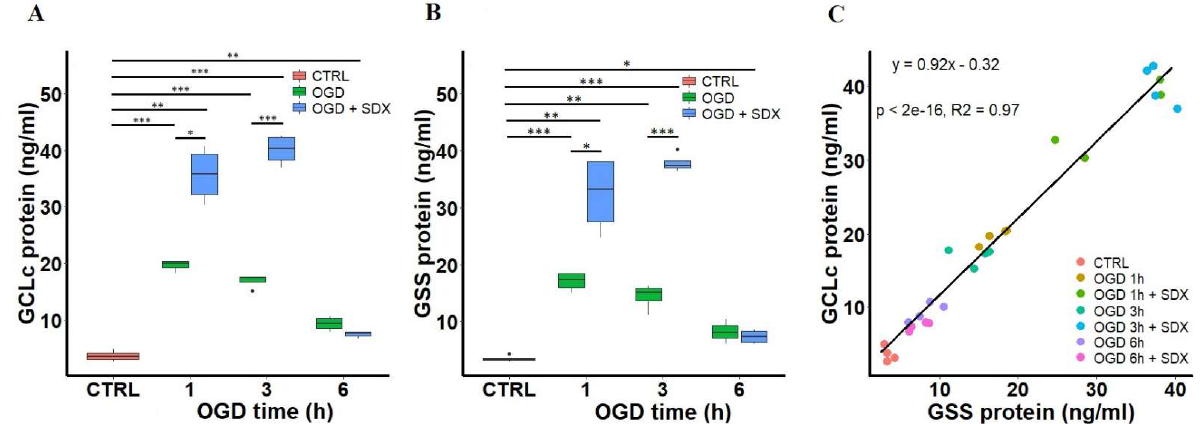
Figure 3. Time-dependent effects of SDX on the protein levels of GCLc and GSS in human endothelial cells subjected to OGD. HUVECs were treated with OGD for 1, 3, or 6 h in the absence or presence of SDX (0.5 LRU/mL). Quantitative analysis of GCLc ( A ) and GSS ( B ) levels in cell lysates was performed by ELISA ( n = 4). The GCLc and GSS protein concentrations (ng/mL) were normalized to total lysate protein. CTRL: normal conditions; OGD: cells exposed only to simulated ischemia in vitro; OGD + SDX: cells exposed to simulated ischemia in vitro and treated with SDX. Data in panels ( A , B ) are box-plots representing the median and quartiles with the upper and lower limits. Significant results are marked with asterisks (* p < 0.05; ** p < 0.01; *** p < 0.001); ( C ) Correlation between GCLc and GSS protein levels. Pearson’s correlation coefficient R 2 = 0.97 was calculated from the linear regression analysis between concentrations of GCLc and GSS in cell lysates obtained from ELISA. [·] is the oulier.